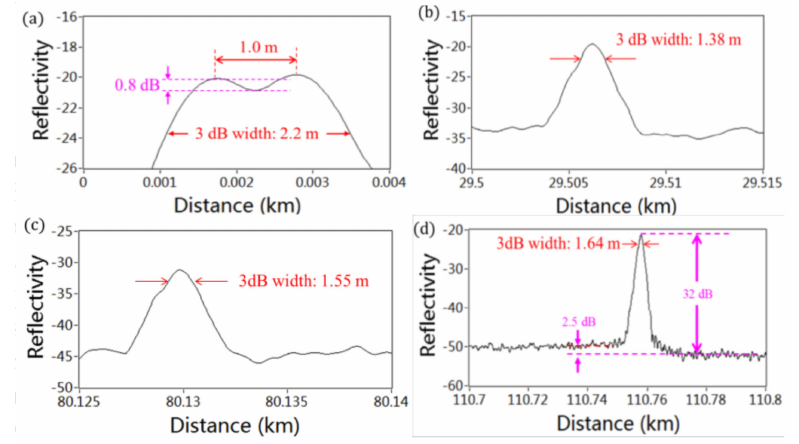
Figure 15. ( a ) Reflection profiles of the pigtail end. ( b ) APC-APC connection at 29.5 km. ( c ) APC-APC connection at 80.1 km. ( d ) Open PC connector at 110.7 km (reprinted from Liu et al. [17] with permission of OSA; copyright